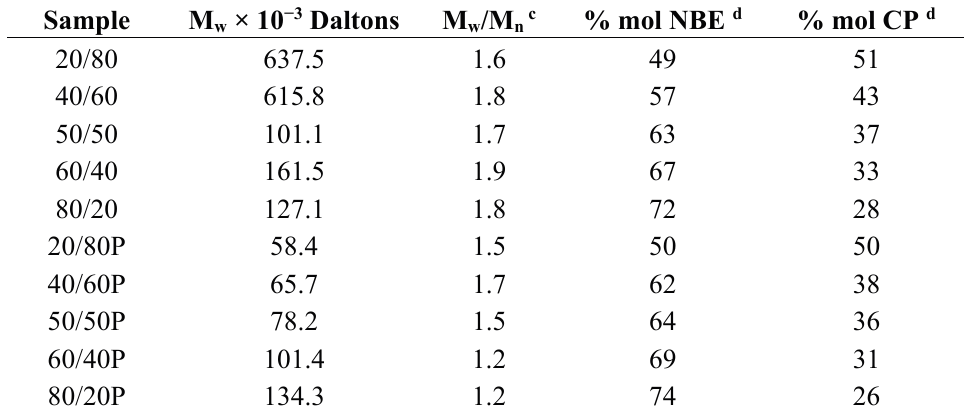
Table 1. Molecular characteristics of the P(NBE- co -CP) copolymers synthesized in the absence a or presence b of PPh 3